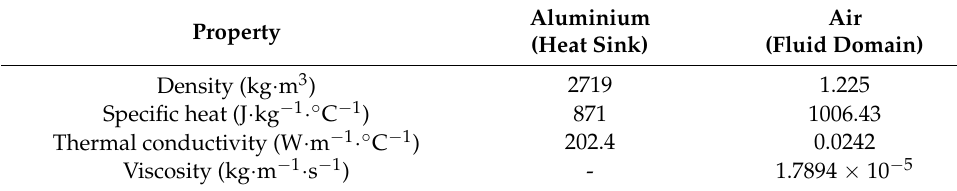
Table 1. Main properties of the materials considered for each component.